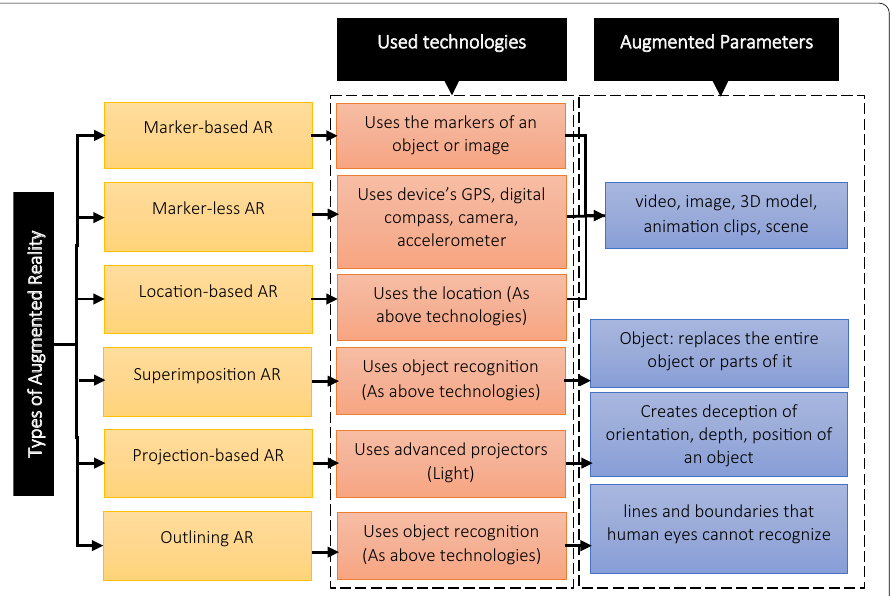
Fig. 1 Various types of AR technologies used tools and technologies, potential augmented